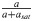
A simple whole-cell coarse-grained model of bacterial growth reproduces proteome allocation and ribosome activity data.(A) Schematic of model structure displaying model components (proteome sectors E, R, Q and X and protein precursor A) and reactions (metabolism, protein synthesis). How the three types of growth rate modulation (nutrient quality, expression of useless protein and ribosome inactivation) are modeled is also highlighted. The rate of precursor creation is proportional to the amount of metabolic enzymes E. The total protein synthesis rate is proportional to the number of active ribosomes, and the synthesis rate per ribosome (the ribosome efficiency) is dependent on the precursor concentration via a Michaelis-Menten relationship. A full description of the model is given in the Methods section. (B) Allocation of total protein synthesis capacity between proteome sectors. A fixed, condition-independent fraction fQ is allocated to housekeeping proteins. Expression of useless protein imposes a fixed allocation fU. The allocation to R proteins is proportional to precursor concentration, and the remainder is allocated to E proteins (assuming that fX≪1). (C-F) Model predictions (solid lines) agree with experimental data (circles–Scott et al. 2010 [13], squares–Dai et al. 2017 [49]). Parameters were all fixed from published data (see Methods). (C) Ribosomal proteome fraction data for nutrient and chloramphenicol growth rate modulations. Colors indicate different nutrient qualities. (D) Relationship between growth rate and useless proteome fraction for forced expression of useless protein. (E-F) Ribosome efficiency (aa+asat) and active ribosome fraction (RaR).